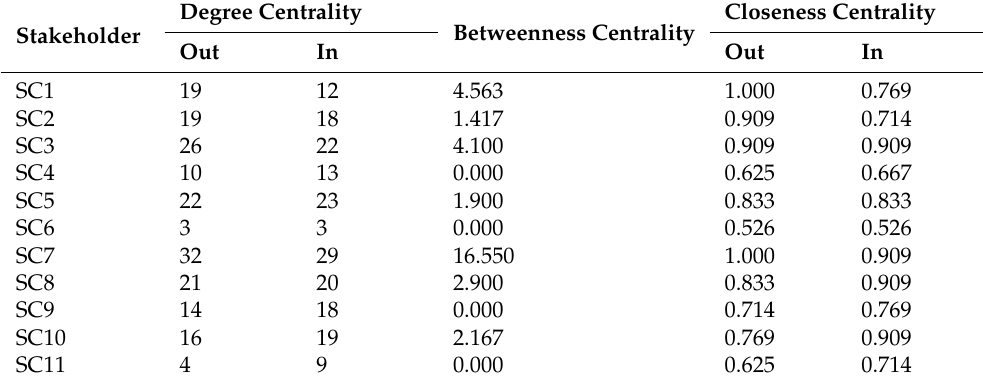
Table 6. Centrality